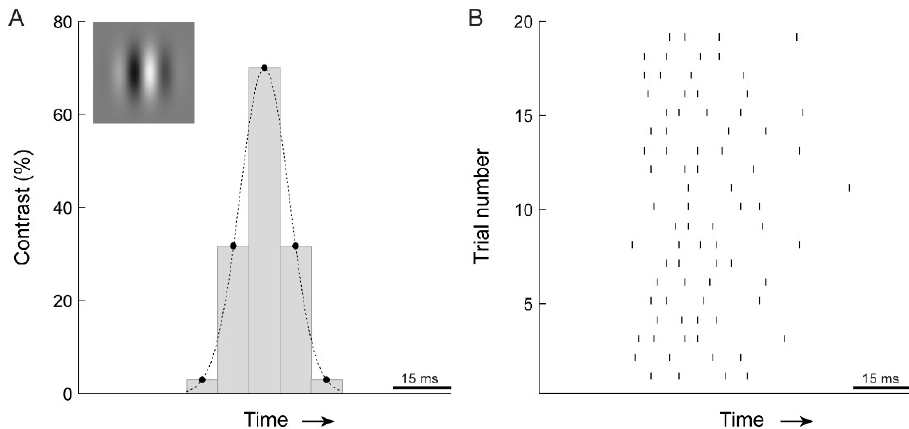
Figure 7. Example showing cat retinal spike response to a stimulus that is detectable by humans. Human observers were asked to discriminate the motion direction of a drifting sine wave grating (16 Hz) in a spatial Gaussian envelope (Gabor patch, top left). ( A ) The contrast of the Gabor patch was Gaussian modulated in time. Presented at 200 Hz, this paradigm allowed very brief presentations of stimulus motion. The example shows the discrete sampling of contrast values ( σ = 7.9 ms, 70% contrast). ( B ) To a drifting sine wave (16 Hz) of the same contrast, a cat retinal ganglion cell